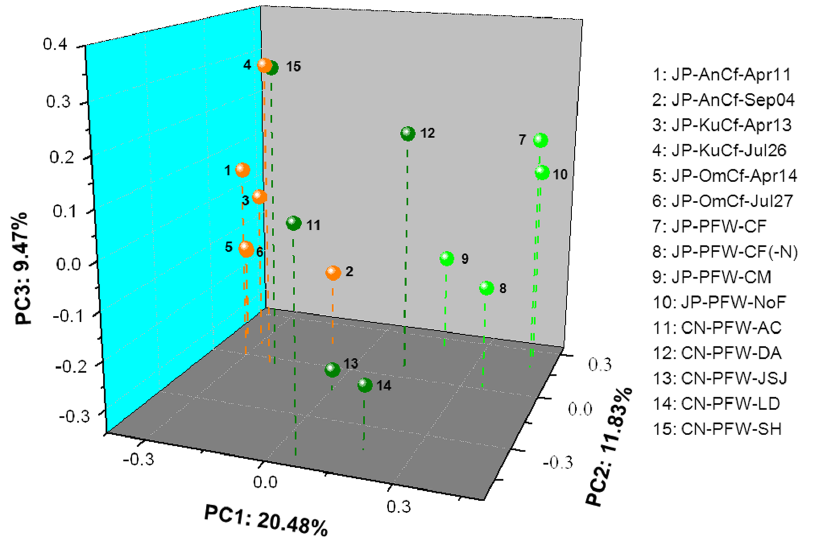
Figure 3. Three-dimensional principal coordinate analysis of g20 clone sequences of cyanophage communities obtained from paddy floodwaters in NE China ( darkgreencircles ) and from Japanese paddy floodwaters ( lightgreencircles ) and paddy soils ( brown circles ). The percentages in the axis labels represent the percentage of variation explained by the principal coordinates.